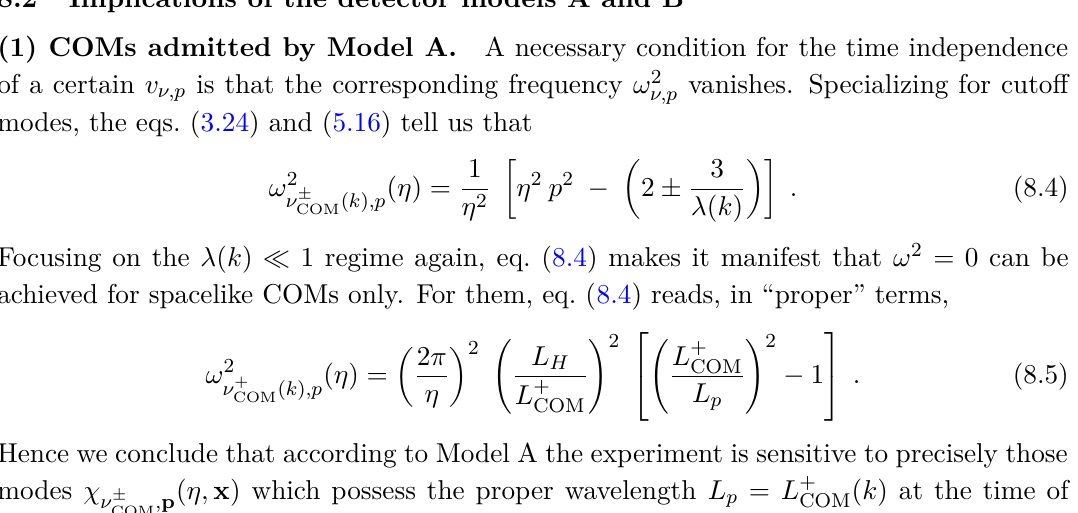
JHEP08(2022)040 ( k ) ≈ L + ( k ) COM COM